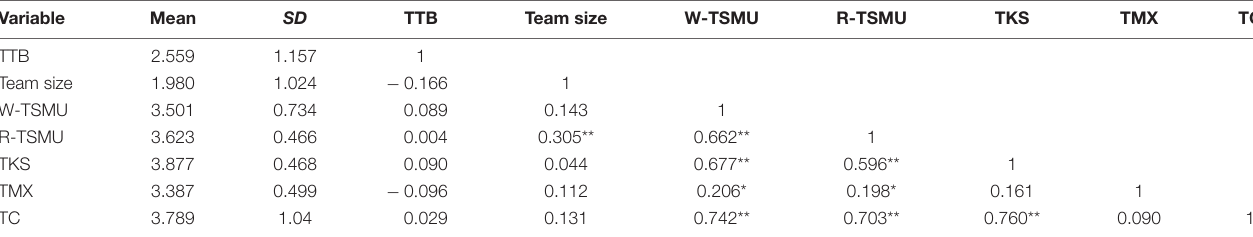
TABLE 3 | Means, standard deviations (SD), and correlations.